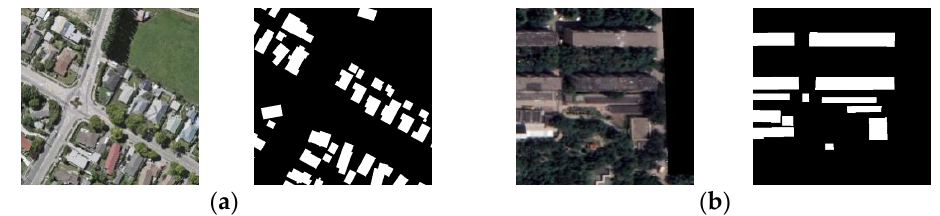
Figure 6. Part of the details of WHU aerial building dataset and Google building dataset of emer- gency shelters within the Fifth Ring Road of Beijing. ( a ) WHU aerial building dataset. ( b ) Google building dataset of emergency shelters within the Fifth Ring Road of